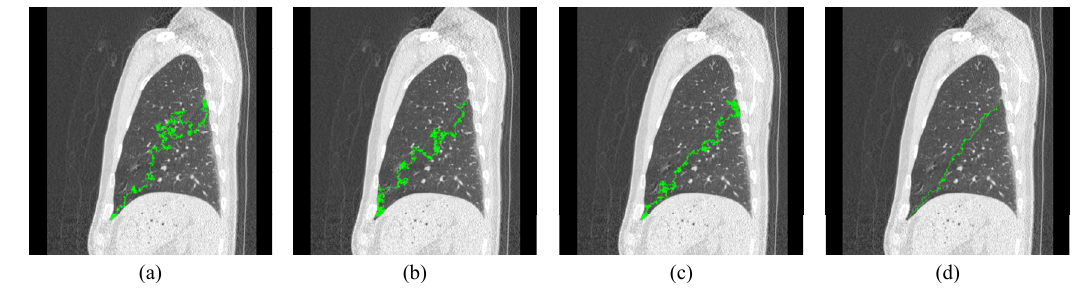
(b) R = 2; (c) R = 3; and (d) R = 5.